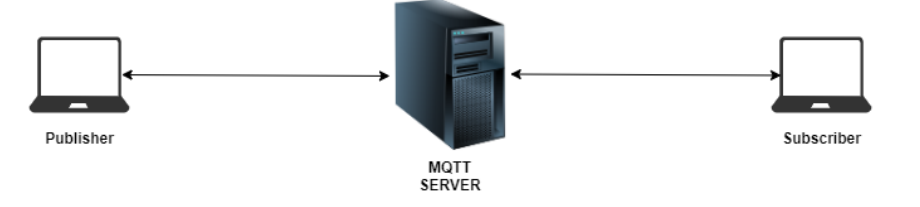
Figure 5. The evaluation environment topology.